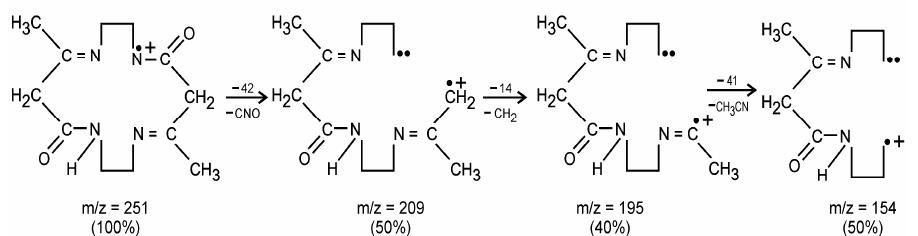
Figure 3. Proton NMR spectrum of macrocyclic